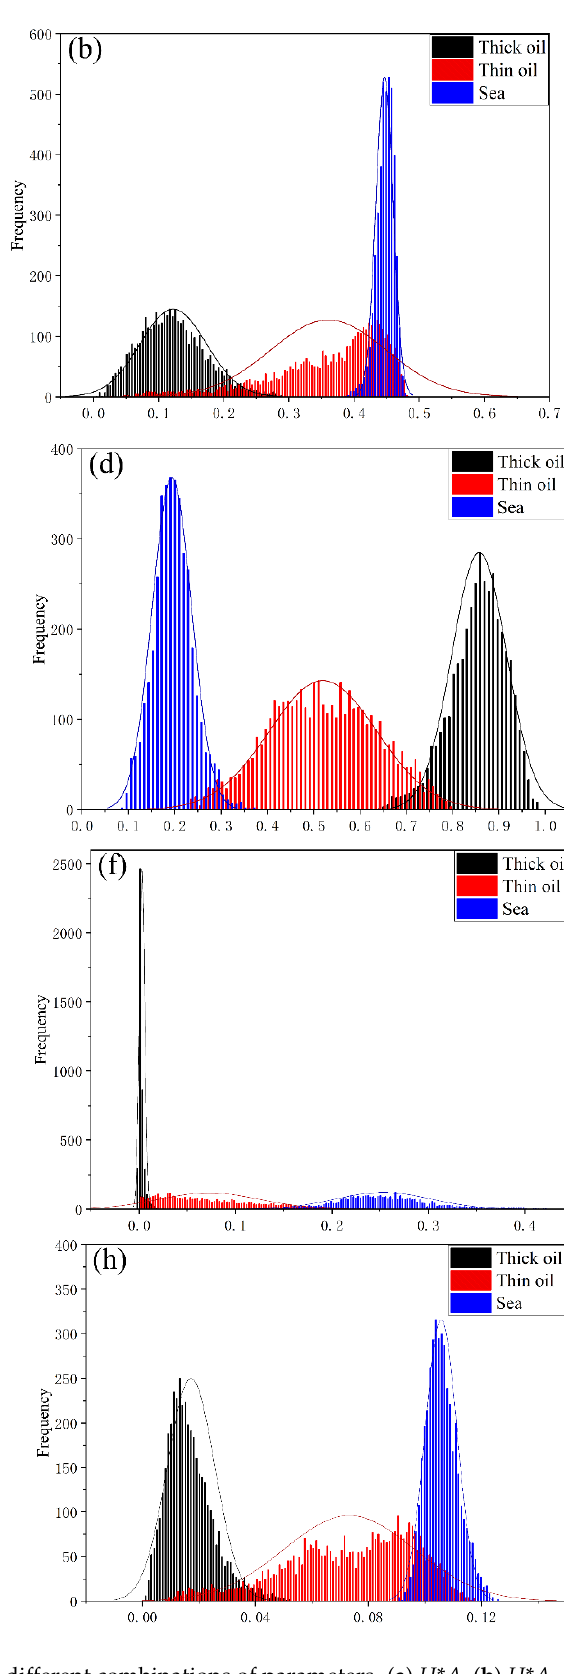
Figure 6. Visual images showing the combination parameters H _ A and H _ A 12 . ( a ) H * A . ( b ) H * A 12 . ( c ) H *(1 − A ). ( d ) H *(1 −